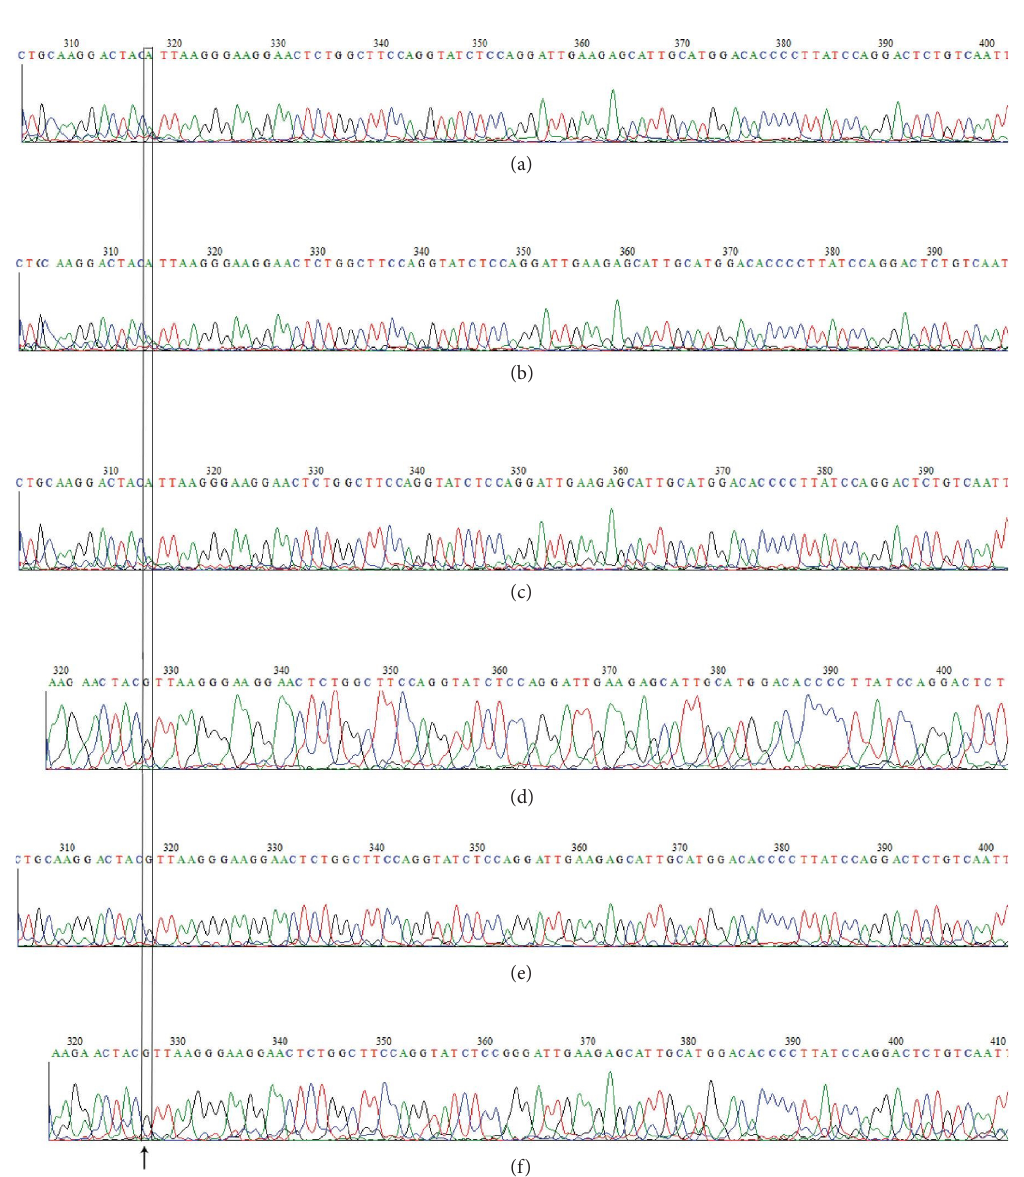
Figure 3: (a–f) A part of sequence chromatogram showing LEP + 328G/A variants. (a) Heterozygous (GA) with A variant in case (P076); (b) heterozygous (GA) with control (C145); (c) heterozygous (GA) with A variant in control C248; (d) homozygous (GG) in control (C063); (e) homozygous (GG) in case (P288); (f) homozygous (GG) in case